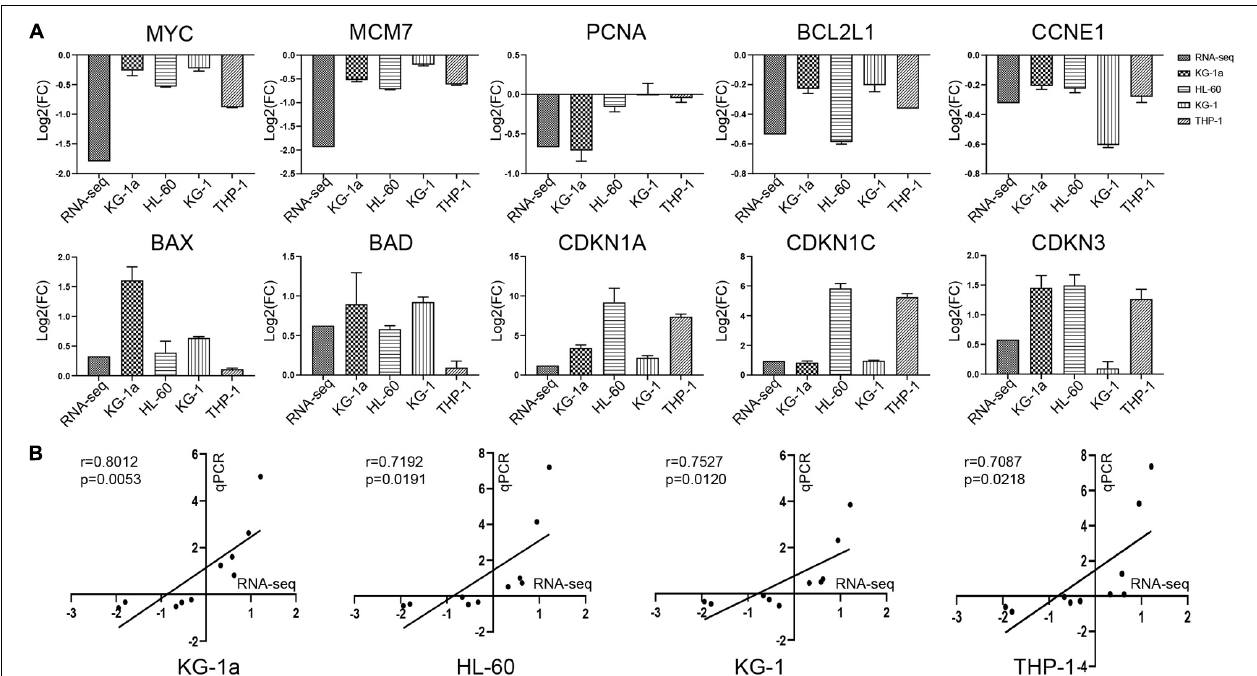
FIGURE 4 | Validation of the RNA sequencing (RNA-seq) with reverse transcription–polymerase chain reaction (RT-PCR). (A) Validation of the data with RT-PCR. The 10 genes identified in RNA-seq data were validated in four different AML cells (KG-1a, HL-60, KG-1, and THP-1 cells) by RT-PCR. The data represent the mean ± SD from three experiments. (B) Correlation of gene expression ratios between RNA-seq and qRT-PCR in four different AML cells (KG-1a, HL-60, KG-1, and THP-1 cells). Data from both RNA-seq and qRT-PCR were normalized by setting the expression level of the untreated control.